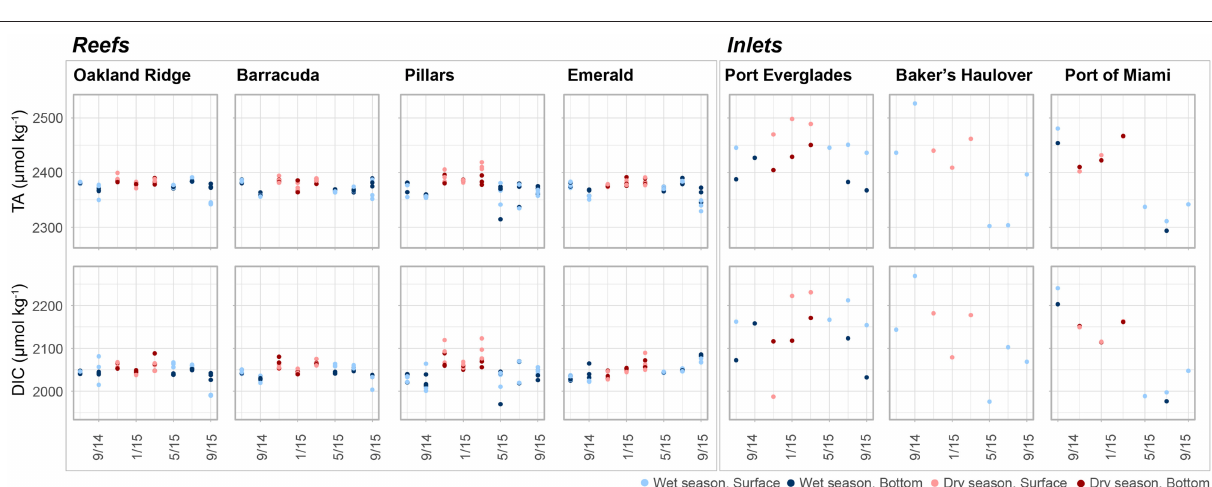
FIGURE 4 | Total alkalinity (TA, µ mol kg − 1 ) and dissolved inorganic carbon (DIC, µ mol kg − 1 ) at four reef and three inlet sites. Data represent each sampling trip, with blue and red points denoting wet and dry season, respectively. Darker colors represent samples taken above the benthos while lighter colors represent samples taken at the surface. An outlier surface sample (2,716.5, 2,557.8 µ mol kg − 1, TA and DIC, respectively) from Port Everglades collected in September 2014 is not shown in order to be better visualize the